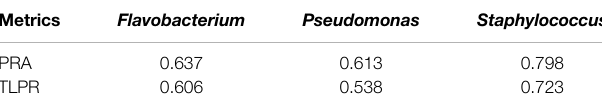
TABLE 3 | Performance under the new data